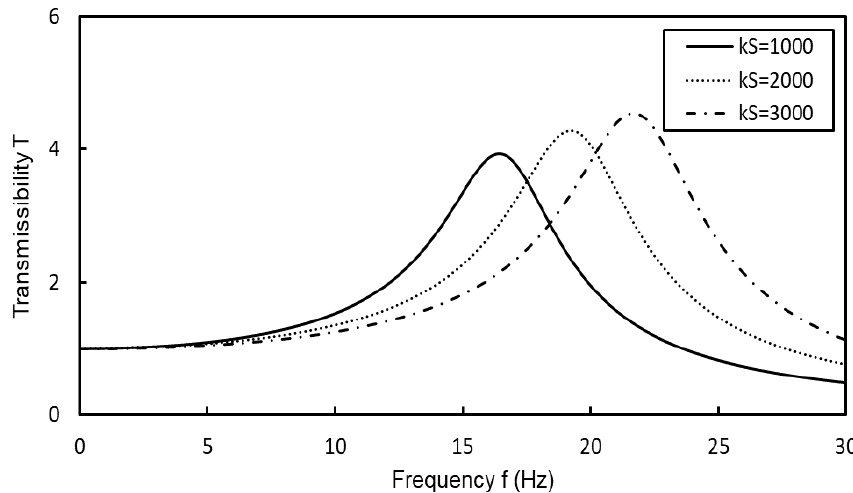
Figure 9. Transmissibility of the non-linear stiffness isolator module of VEAM with varying values of k s .